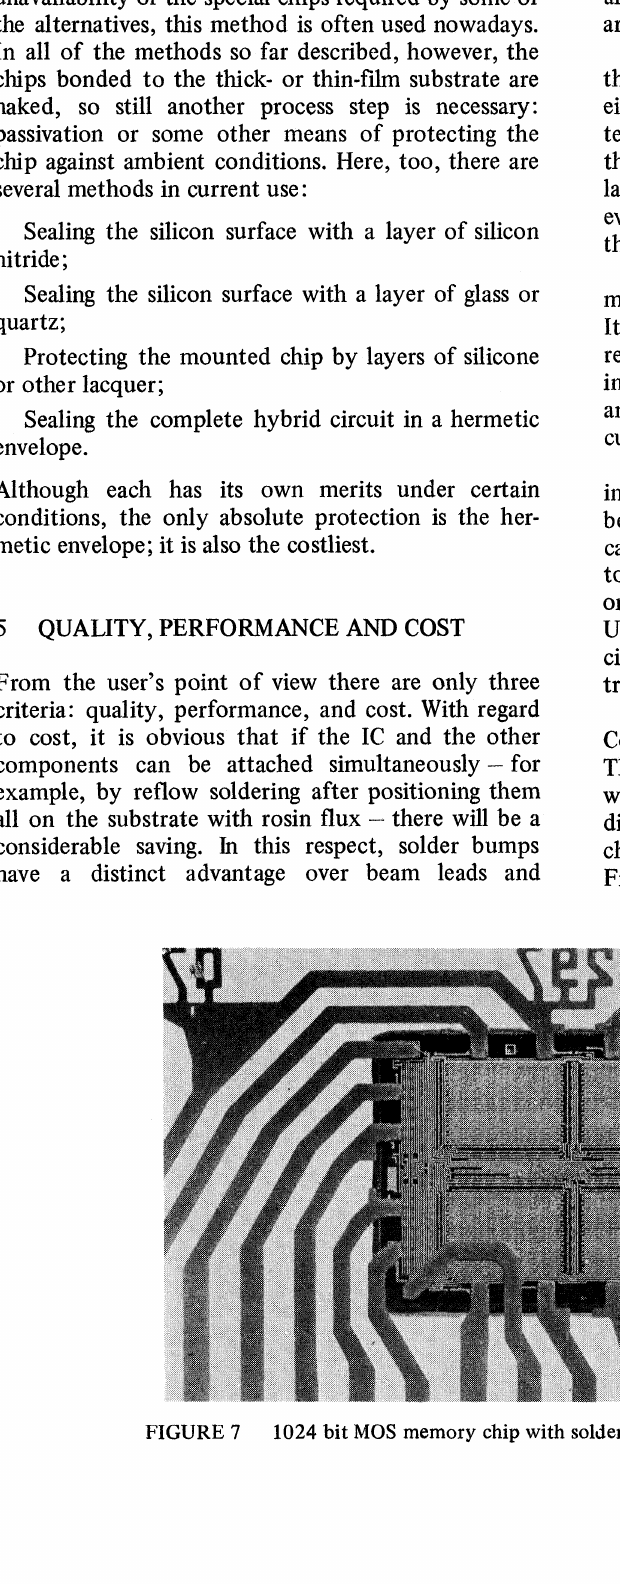
1024 bit MOS memory chip with solder-balls attached to polyimid foil (Approx.